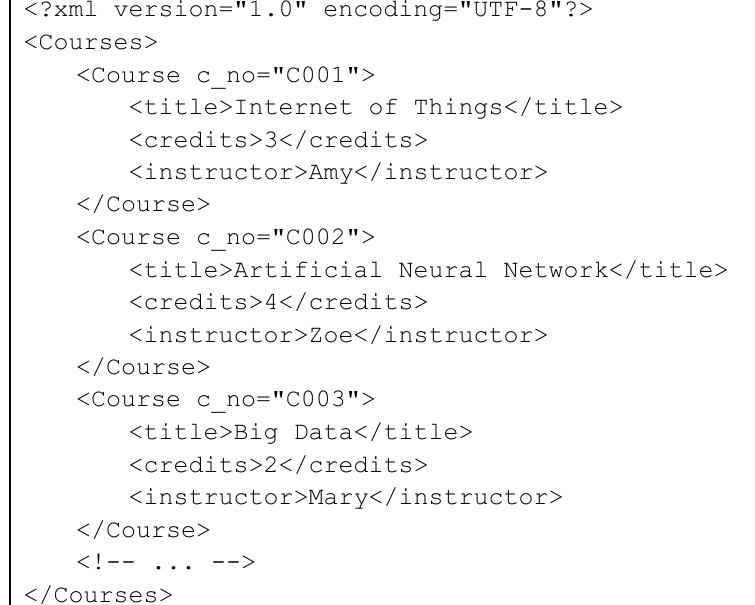
Figure 6. An example of a data file in an XML database.